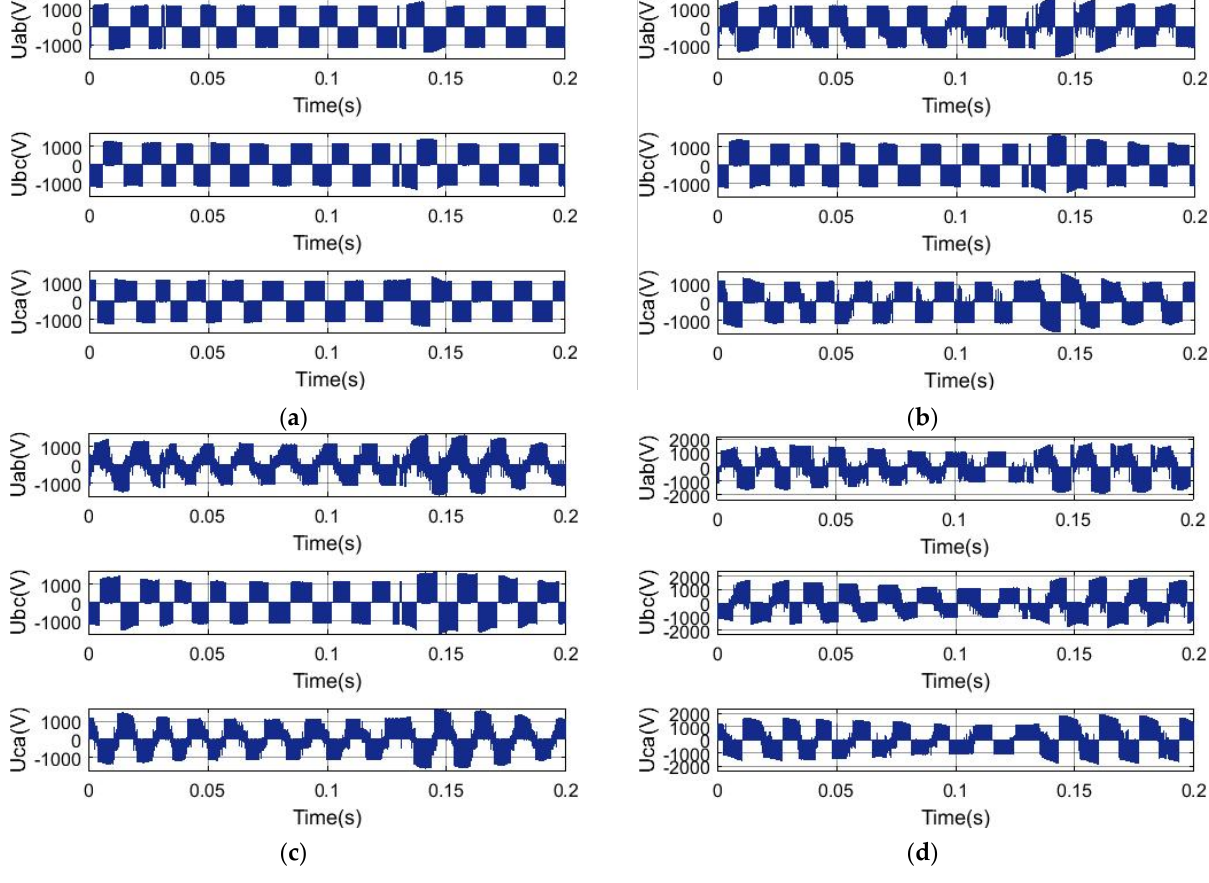
Figure 2. The simulated voltage U abcg ( U ab , U bc , U ca ). ( a ) Normal state; ( b ) OC fault occurred in T1; ( c ) OC fault occurred in T1 and T2; ( d ) OC fault occurred in T1 and T3.